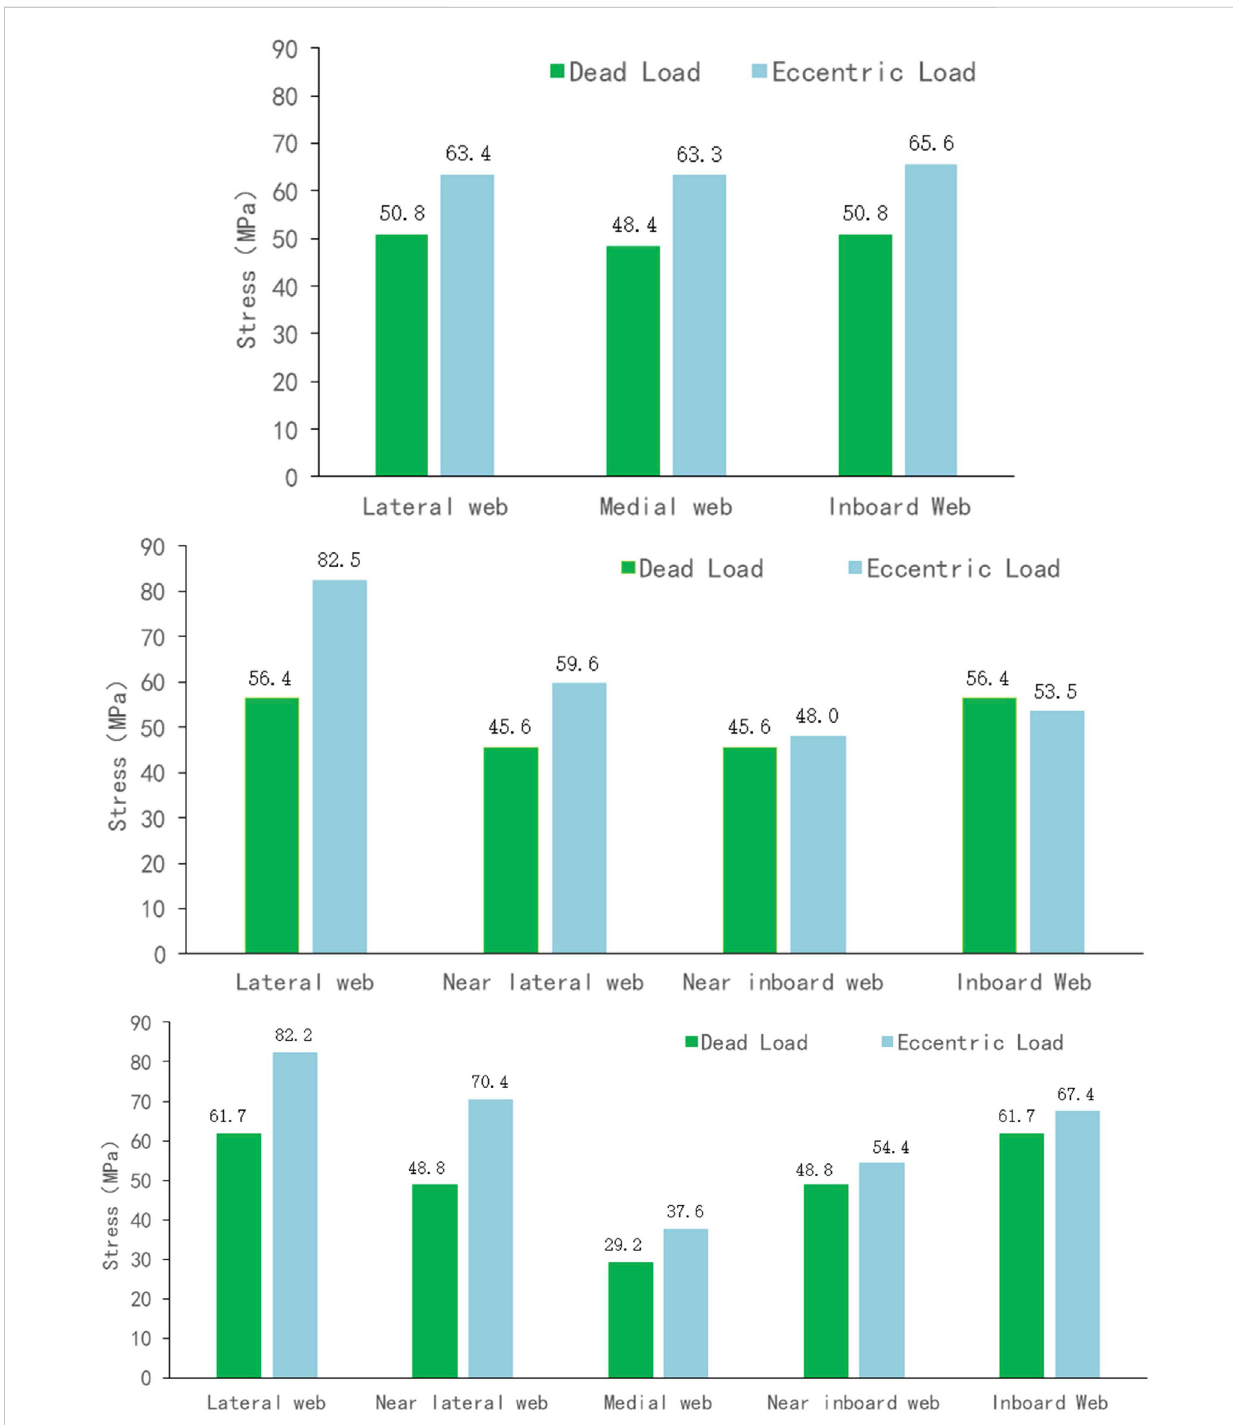
Comparison of web stress of straight